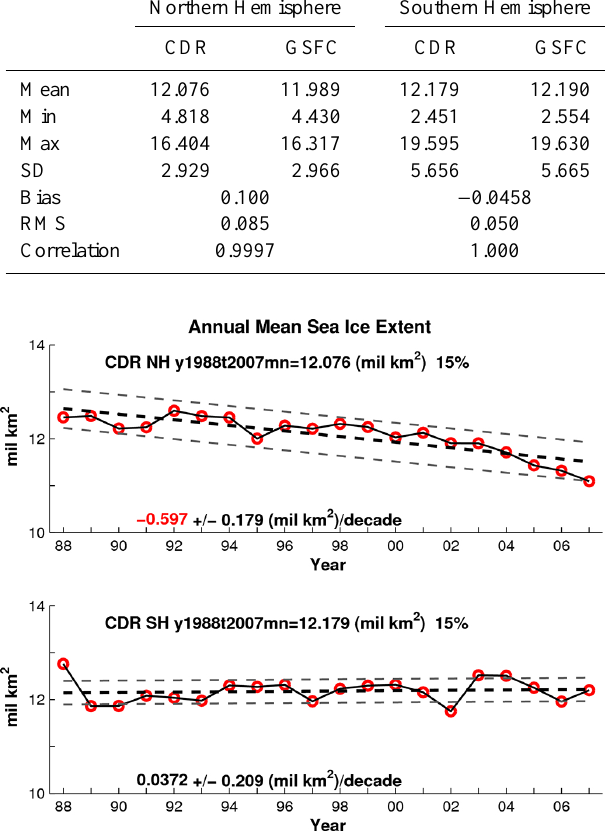
Figure 6. Annual mean CDR sea ice extent from 1988 to 2007 (red circles), with the linear regression ± 1 standard deviation of the an- nual mean sea ice extent (black and grey dashed lines, respectively) for the Northern (top) and Southern Hemisphere (bottom) with the decadal trend and its margin of error – trend in red is significant at the 95% confidence